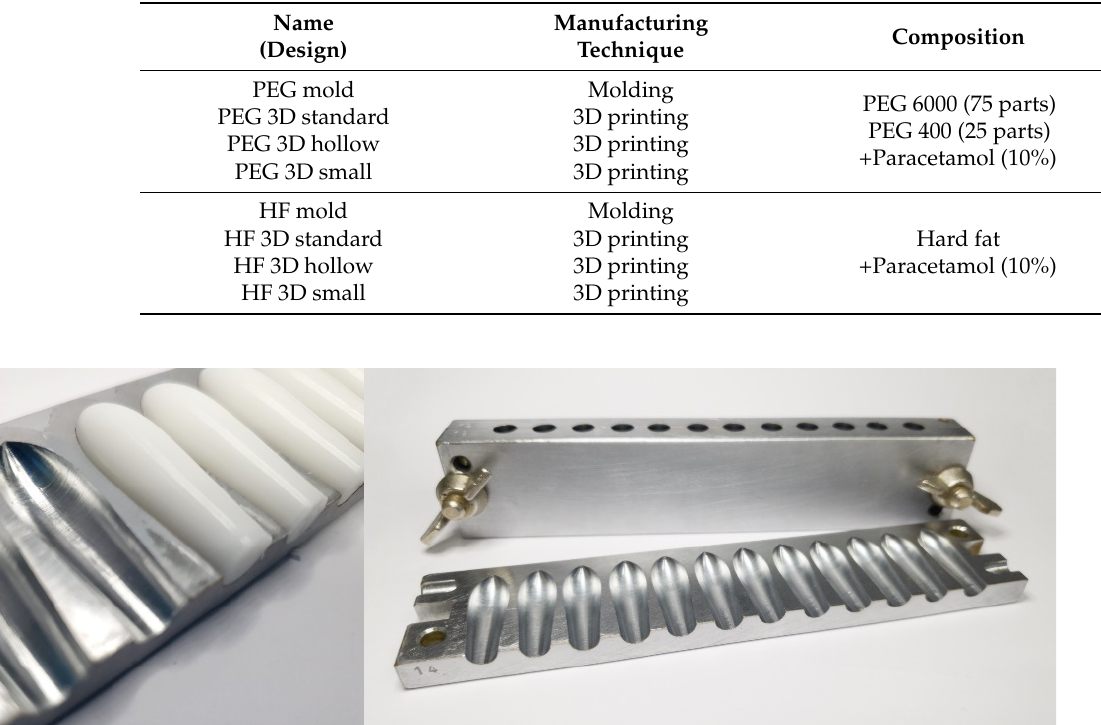
Figure 1. Metallic suppository mold with suppositories of hard fat.